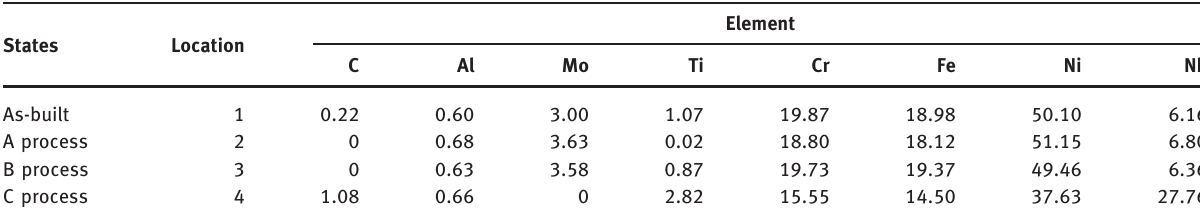
Table 3: The EDS analysis of segregations and precipitates on the X-Y surface of alloys （ wt.% ） .